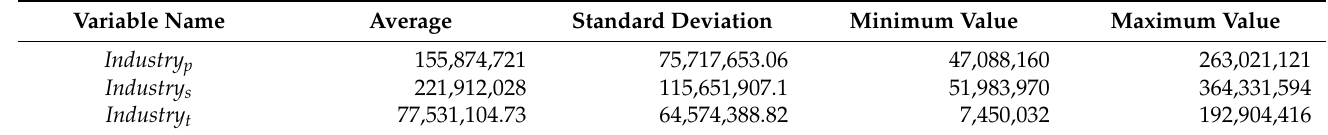
Table 1. Descriptive statistics table of China’s three major forestry